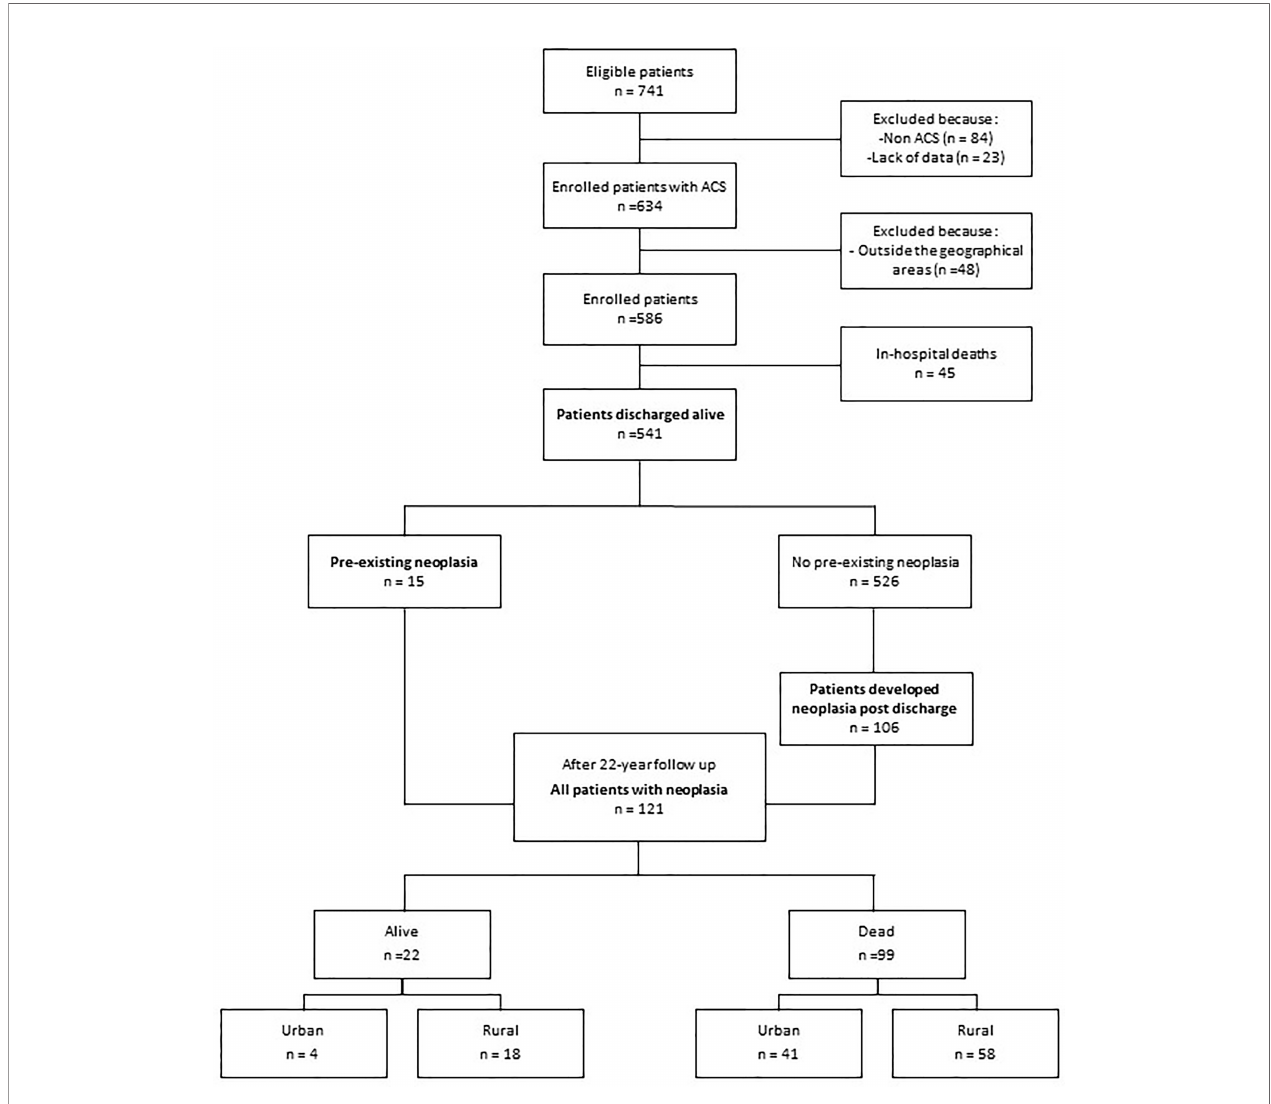
FIGURE 1 | Flow diagram of the study population and progress during follow-up. ACS, acute coronary